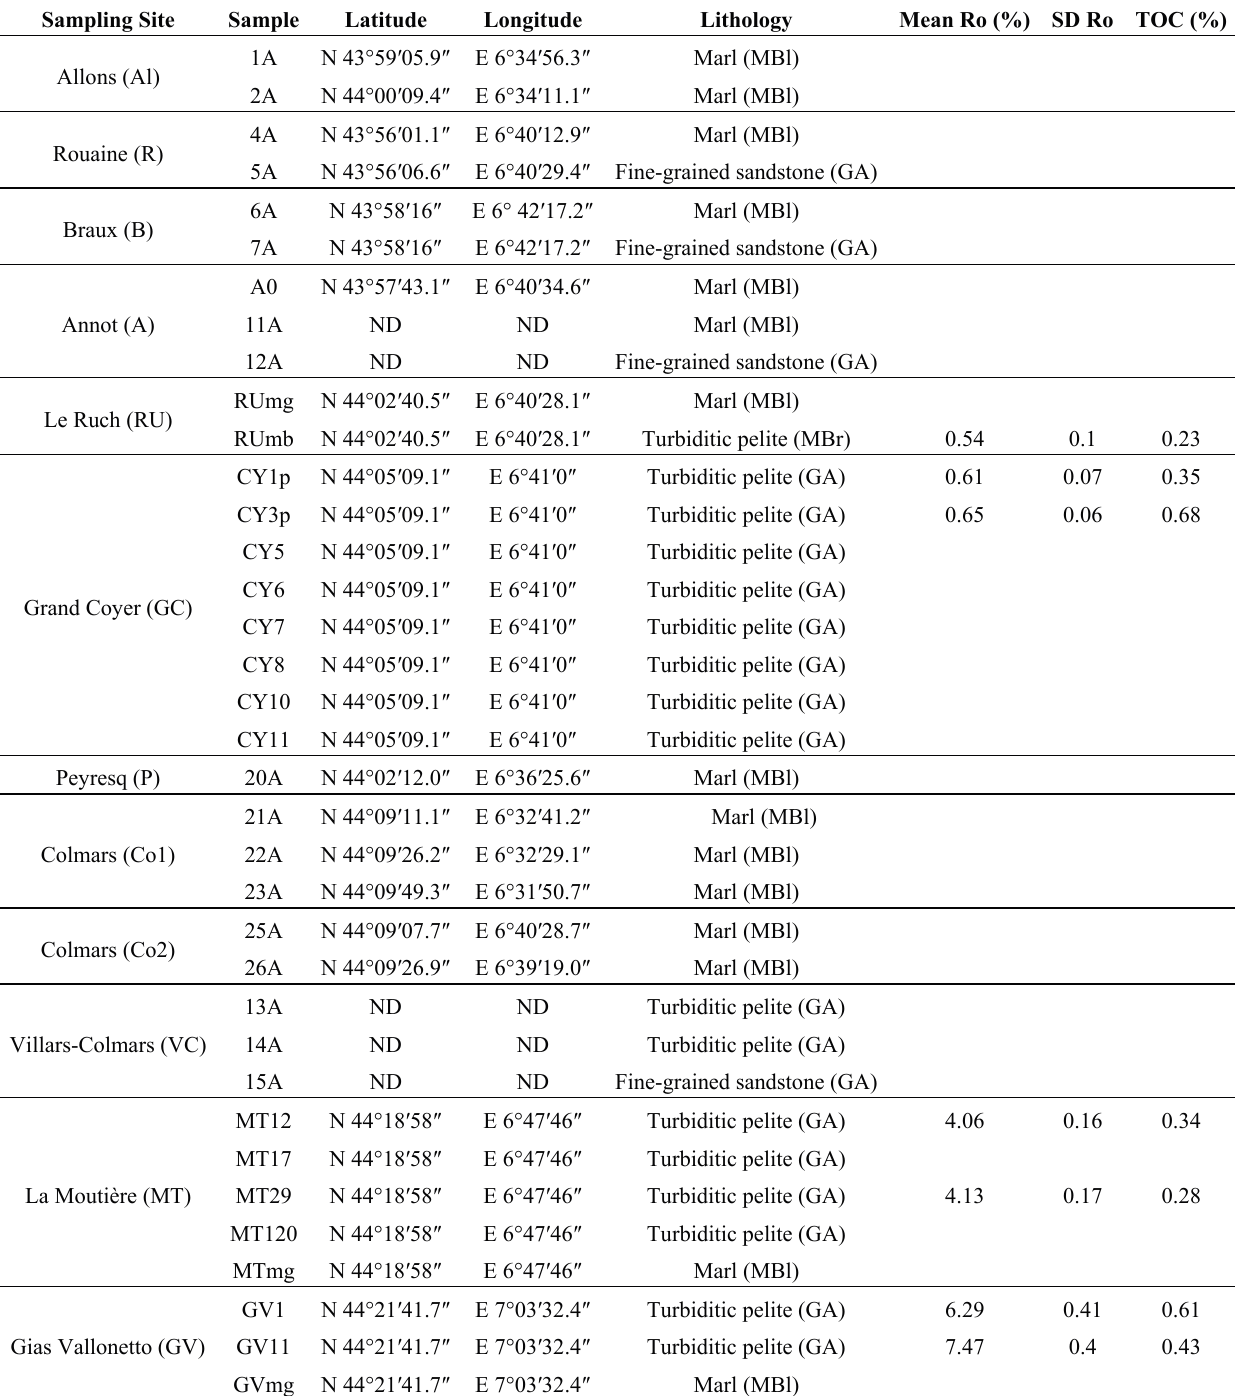
Table 1. Location of the sampling sites (ND: no data). The lithology and name of the formation in brackets are reported. MBl: Marnes Bleues; MBr: Marnes Brunes; GA: Grès d’Annot. Vitrinite reflectance data (Ro) and total organic carbon (TOC) content are also mentioned. SD: Standard